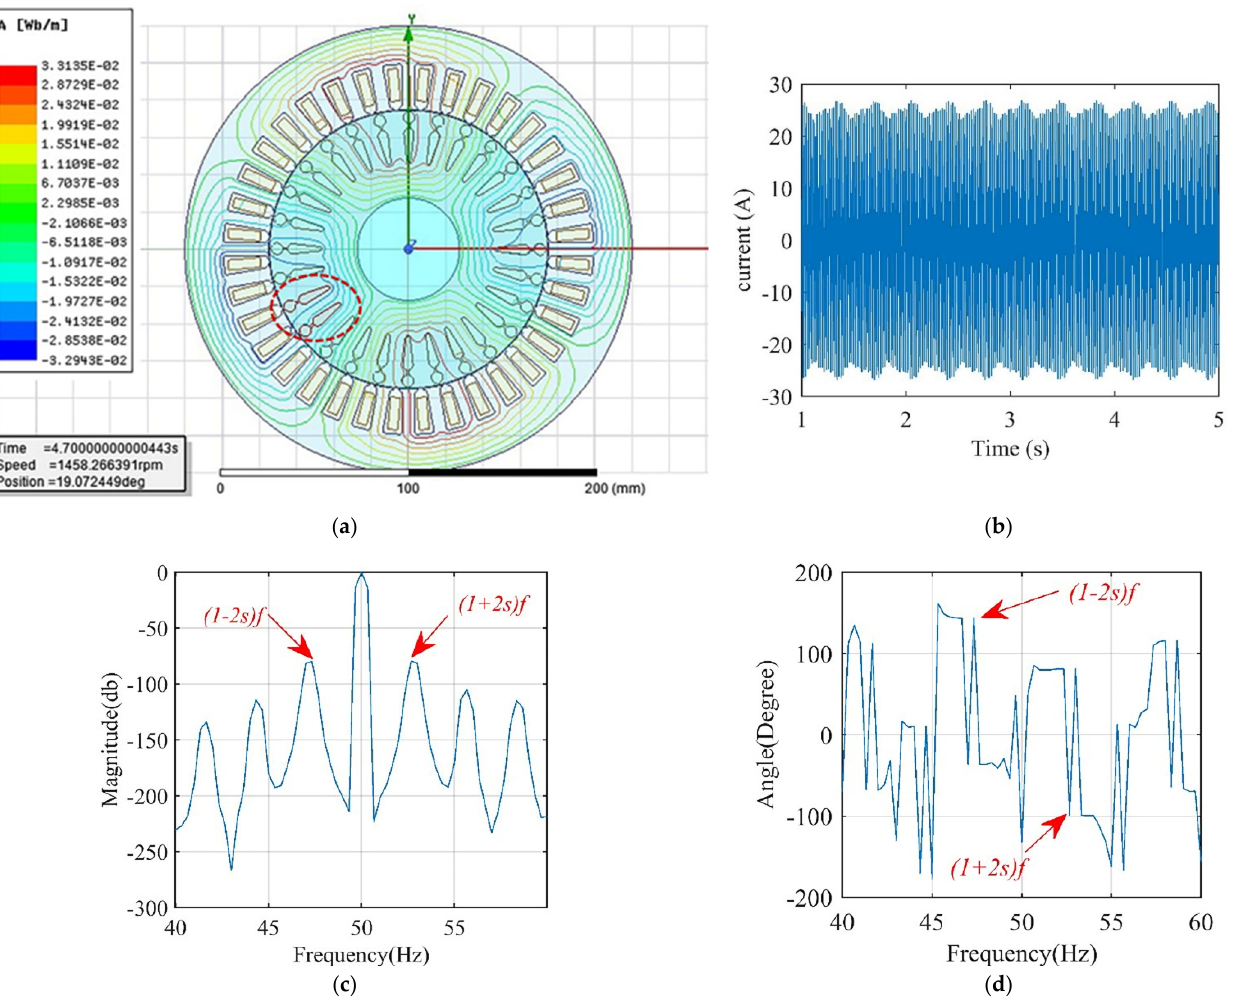
Figure 1. Characteristics for modeling Motor I with 2 BBR. ( a ) The magnetic flux lines distribution. ( b ) Periodic oscillation in the stator current envelop. ( c ) The main sideband frequency components for stator current (40–60 Hz). ( d ) Phase angle of the main sideband components.